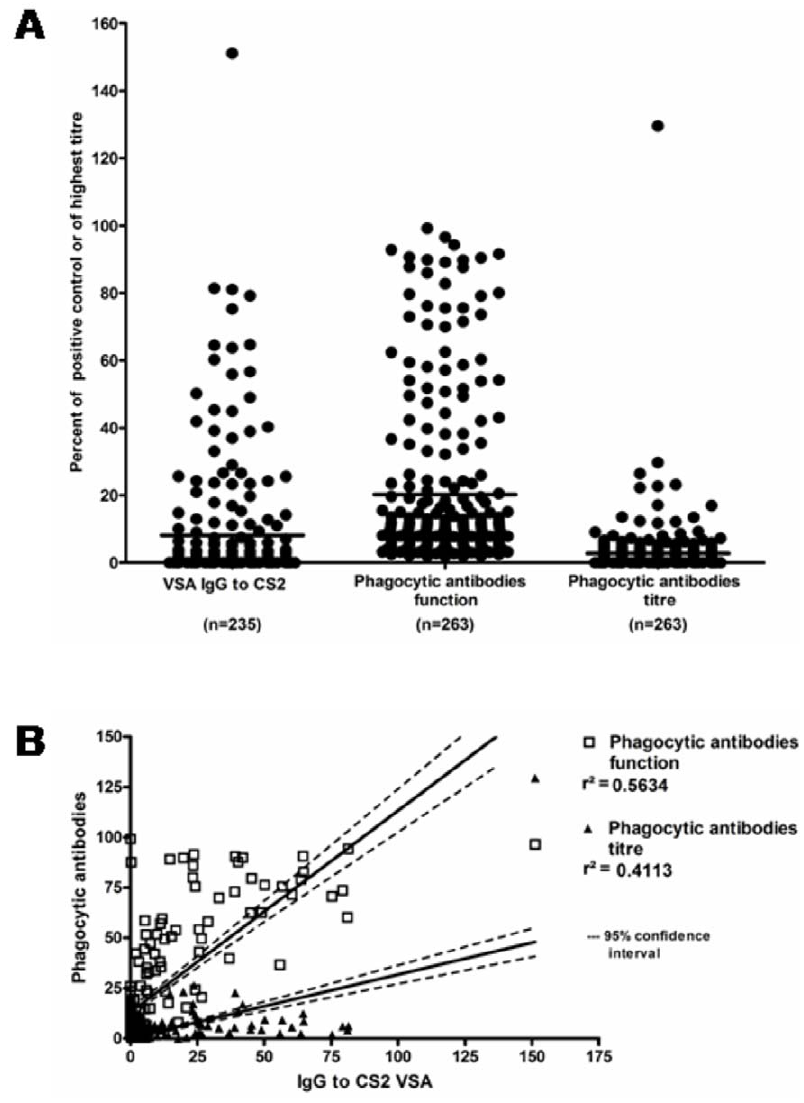
Figure 2. Distribution of, and correlation between, antibody parameters measured. A) Dot plot representation of the distribution of values obtained for VSA IgC to CS2, and both phagocytic antibodies’ parameters. n= number of samples analysed in each group. B) linear regression analysis of VSA IgG to CS2 and both function (open squares) and titre (full triangles) of phagocytic antibodies. Analysis performed on GraphPad Prism v4.0 maternal haemoglobin levels, infant birth weight nor HIV impacted on IgG to CS2 VSA (table 3).